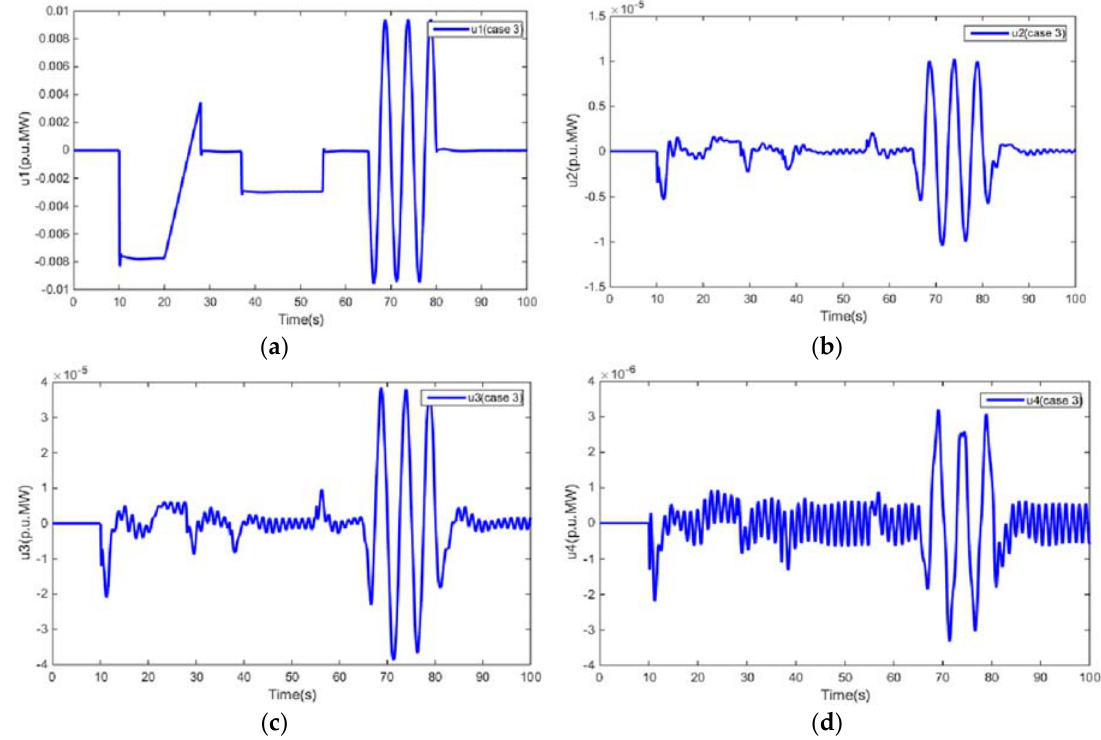
Figure 8. Control signals from controller of four areas in Case 3: ( a ) control signal u 1 ; ( b ) control signal u 2 ; ( c ) control signal u 3 ; and ( d ) control signal u 4 .